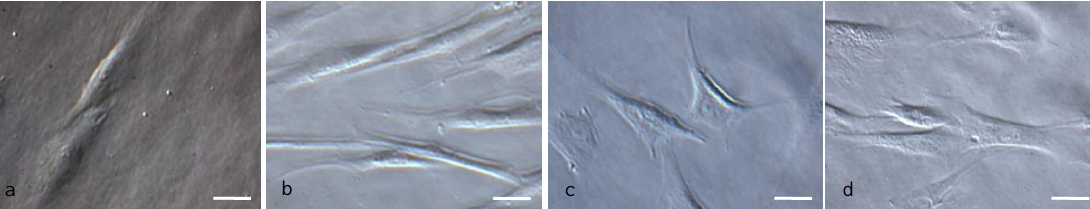
Figure 5. The effect of 5-Aza on cardiomyocyte-like cells differentiation of hMSCs in vitro. ( A ) The morphological changes of cardiomyocyte-like cells differentiation were photographed under a microscope. Scale bar, 20 μm; ( B ) Currents recorded in a patch clamped cell. As shown in Figure, compared with the hMSCs group, Cr and Scr group fired apparent action potentials. There were no significant differences on action potential between Cr and Scr groups. Compared with Cr and Scr group, SSH1L prolonged APD and elevated population spike. The voltage steps of SSH group applied in 100 mV increments from −70 mV to +30 mV from a holding potential of −70 mV. But contrast to CMs, SSH group cells have weaker action potential; RT-PCR ( C ) and Western blot ( D ) analysis for the expression of CM-specific genes and proteins, which were increased after 5-Aza